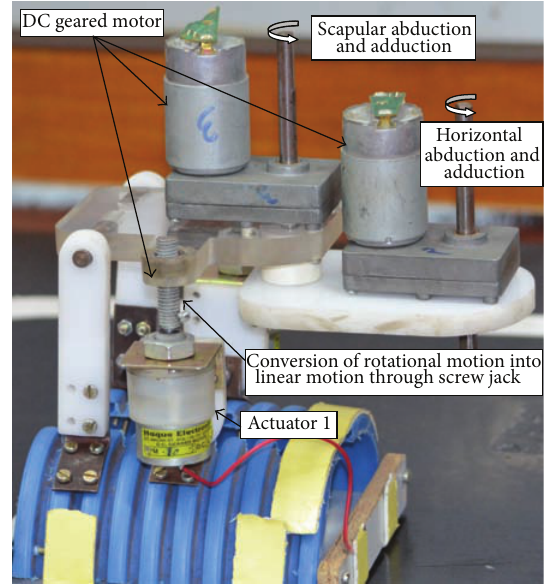
Figure 4: Manufactured model of shoulder griddle.